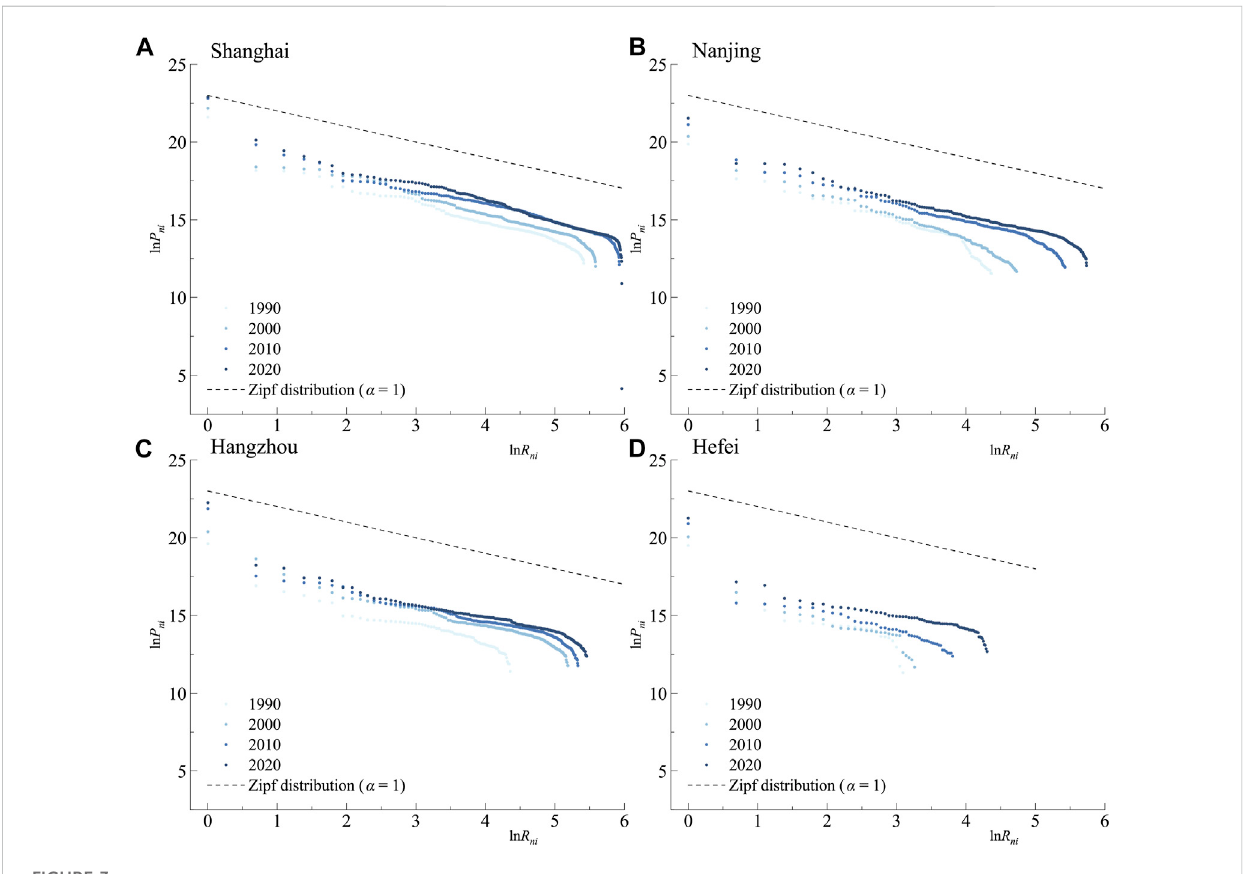
FIGURE 3 Intra city-size distribution of YRDR (key